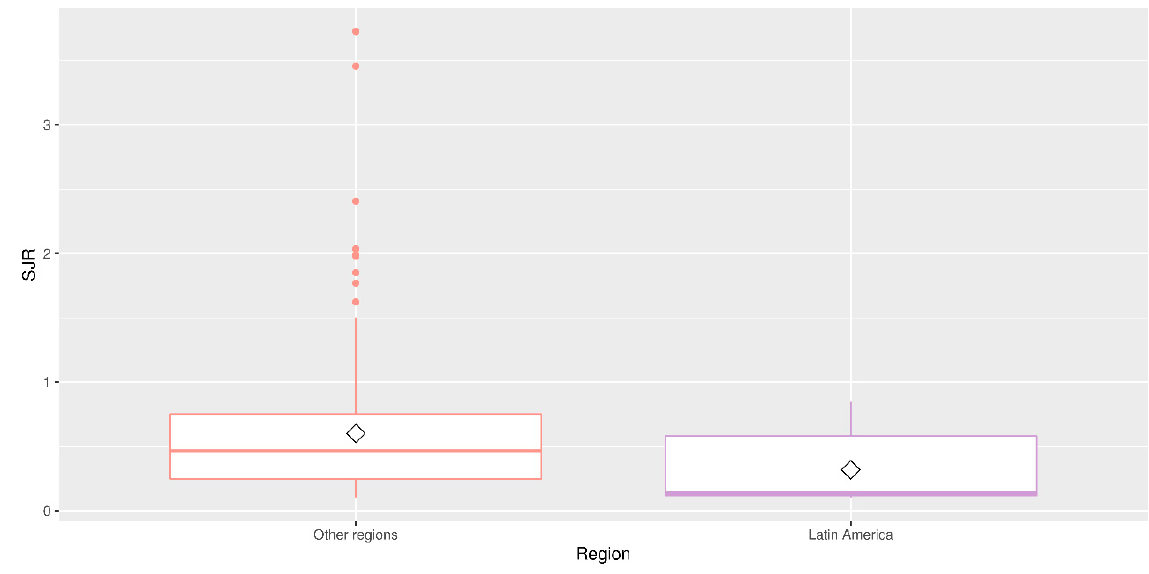
Figure 5. Comparison of SJR between LAC and other regions.